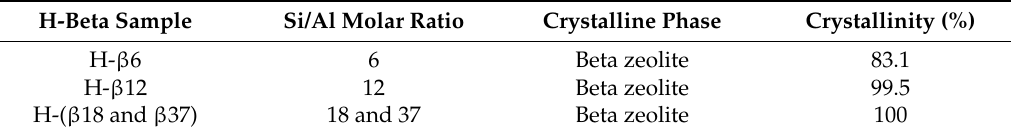
Table 1. Crystallinity of the H-Beta sample, calculated with Equation (1).